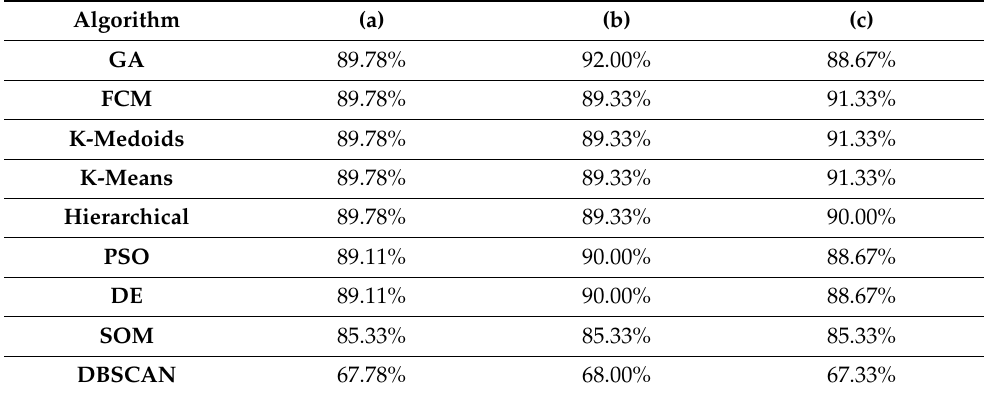
Table 1. Clustering algorithm performances considering the use of PCA on the Iris dataset.